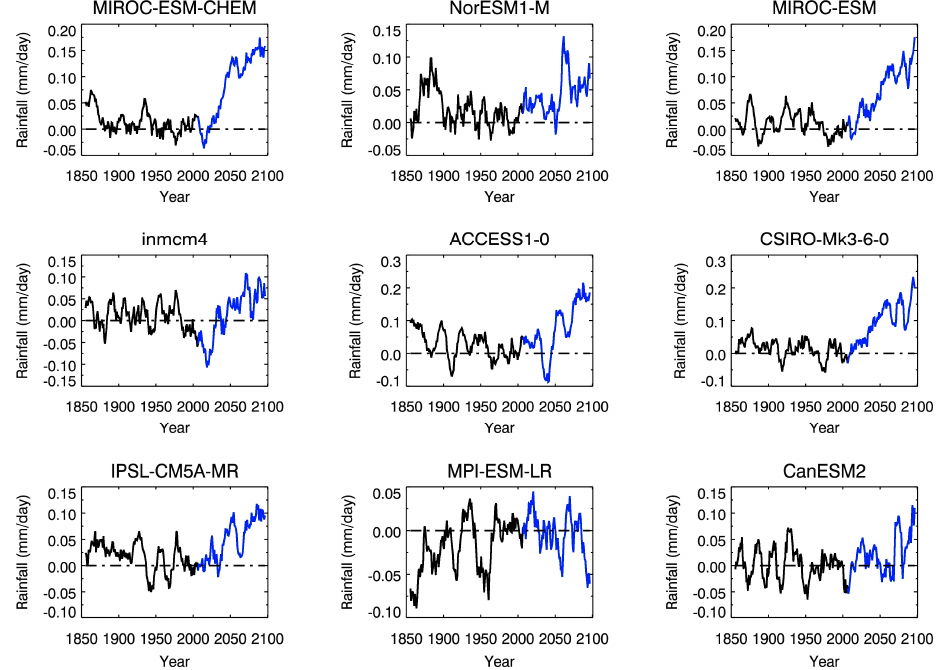
Figure 4. The eleven-year running mean of ISM precipitation time series in the CI region is presented for the historical (black) and RCP 8.5 (blue) scenario for various CMIP5 model outputs . The anomaly is calculated relative to a period (1985–2005).